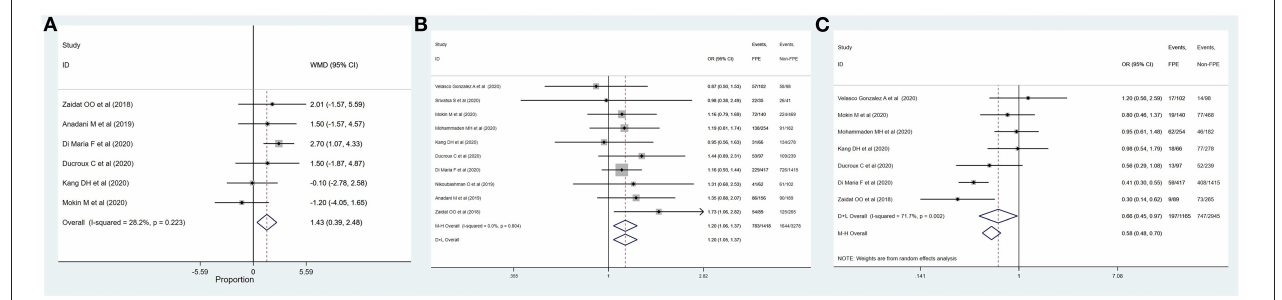
FIGURE 4 | Determinants of achieving complete recanalization with FPE. (A) Age; (B) female; (C) ICA.